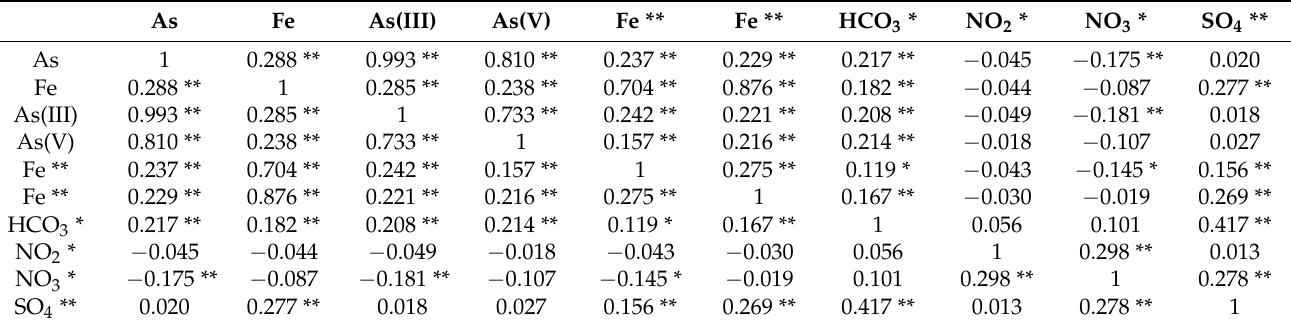
Table 7. Pearson correlation analysis between As and the main redox ions in the Hubao Plain ( n = 278).